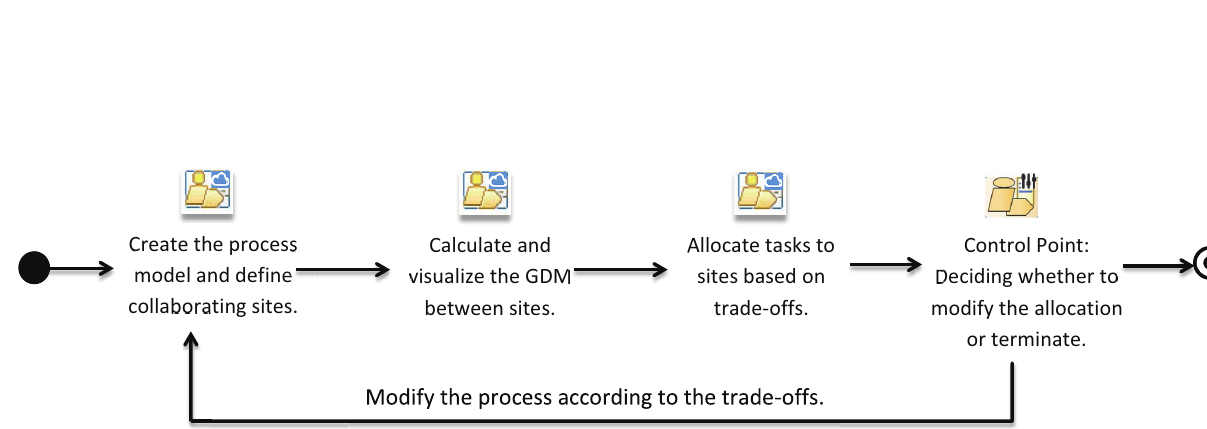
Fig. 5. The decision making